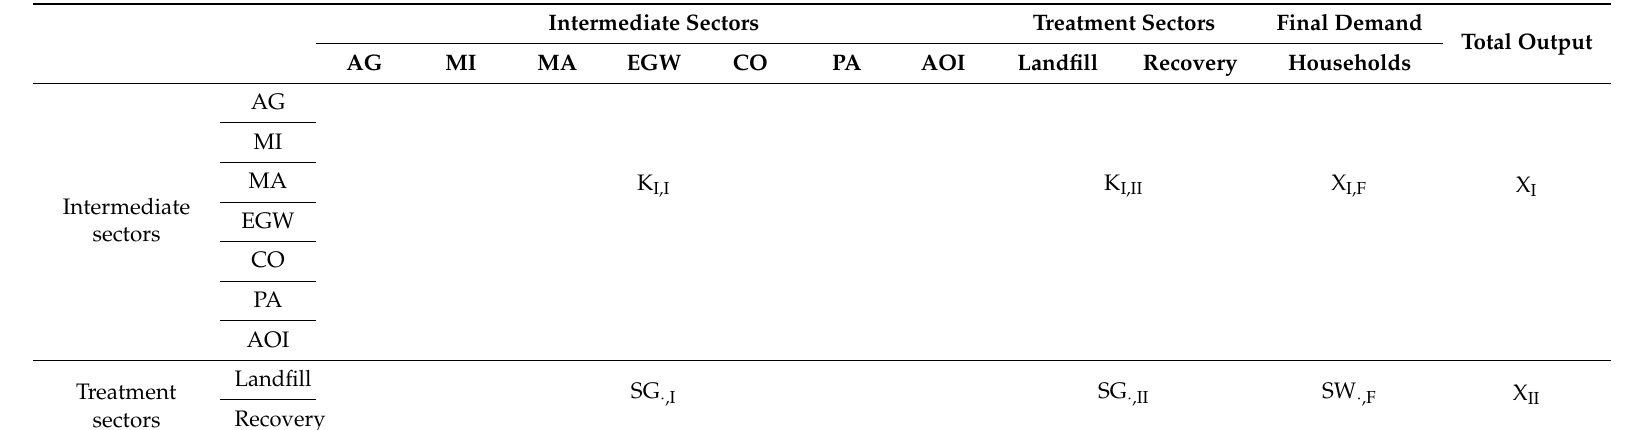
Table 2. An aggregation waste input-output (WIO) framework based on various sectors of the Australian